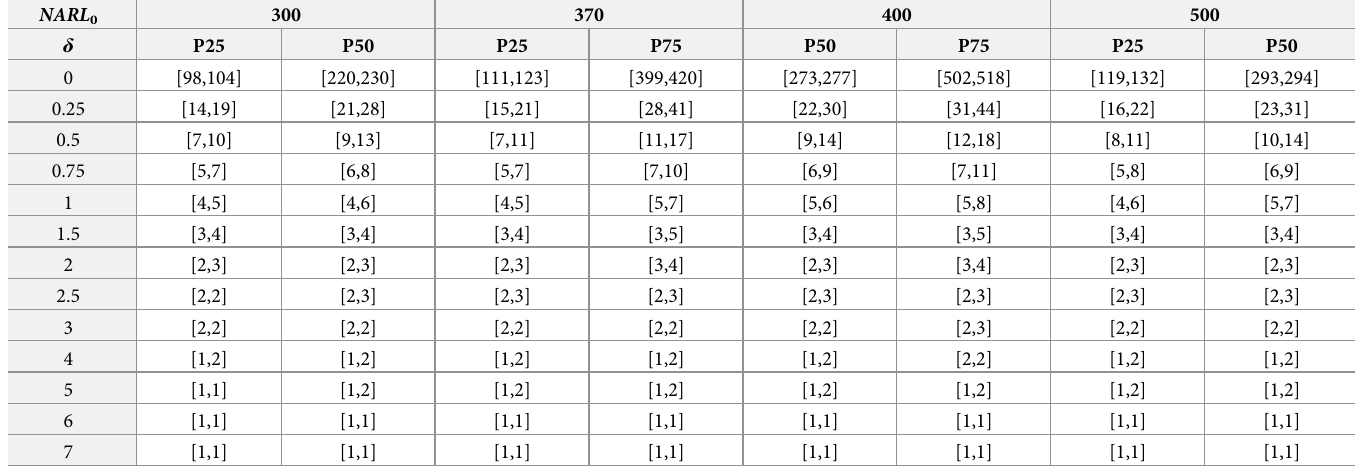
2 [3, 5], k 2 [0.20, 0.25] for different nominal NARL . N N